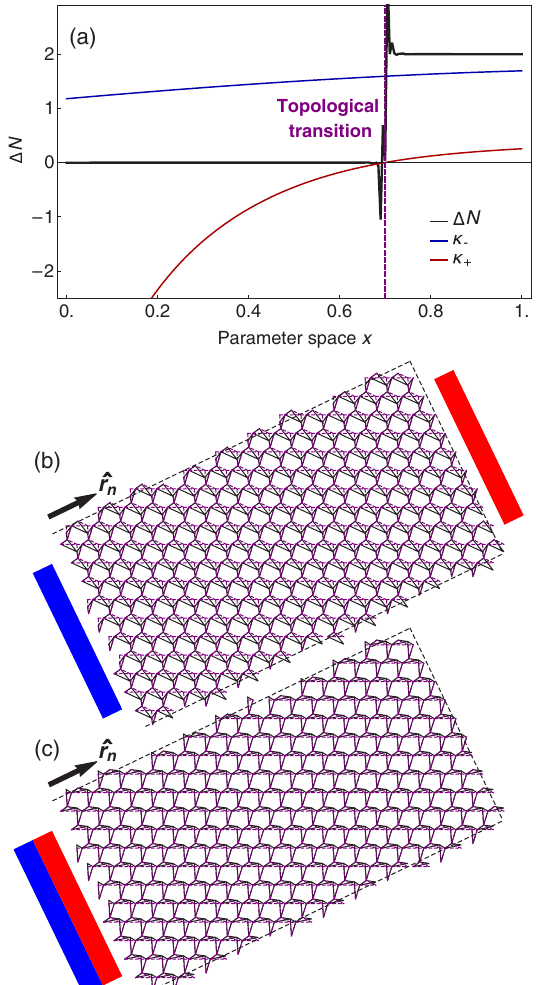
FIG. 4. (a) Topological transition as we deform the kagome lattice. The geometry of the system is parametrized as g ð x Þ ¼ x g 1 þ ð 1 − x Þ g 2 , where g 1 , g 2 are geometric configura- tions of two kagome systems with respective topological polar- izations 0 and 2 along the ˆ r direction. Note that κ are the signed n (cid:3) inverse decay lengths, such that, when one vanishes, the associated mode lies in the bulk and, when both have the same sign, the system is polarized. (b) The system in the g 1 configu- ration with trivial polarization: There is a zero mode on the left side of the considered orientation ˆ r and one on the opposite side. n (c) The system in nontrivial polarization ( Δ N ¼ 2 ): This time, the two modes are on the left side of the direction. In all three figures, the purple dashed lines represent the shape of the system at the topological transition (when x ¼ 0 . 7 ).